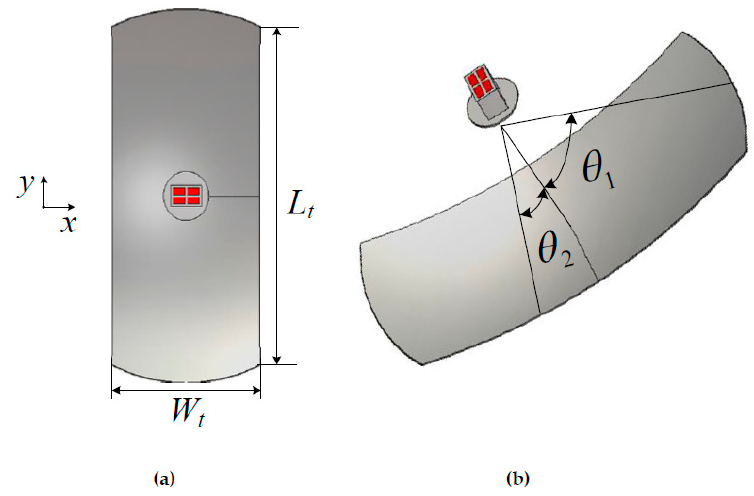
Table 2. Dimensions of the truncated parabolic reflector.